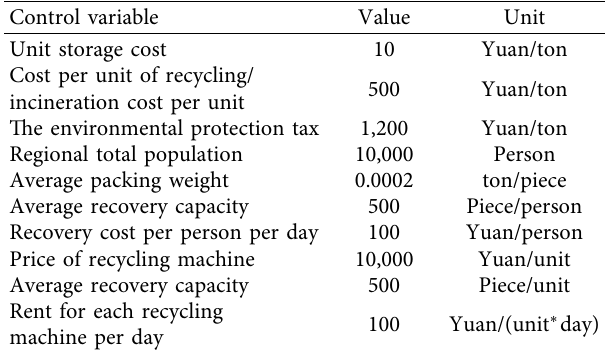
Table 2: Related parameters of double-beam-channel packaging recycling model simulation